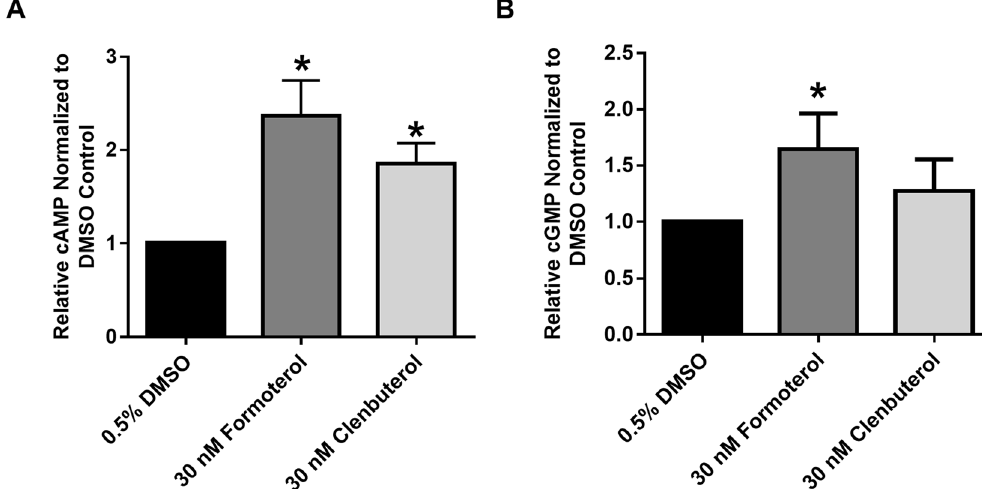
Figure 1. Formoterol and clenbuterol increase cAMP ( A , N = 3) but only formoterol increases cGMP ( B , N = 6) in RPTC. Levels of cAMP/cGMP were measured 1 h following treatment with formoterol or clenbuterol. Mean + SEM. * p < 0.05, Wilcoxon signed rank